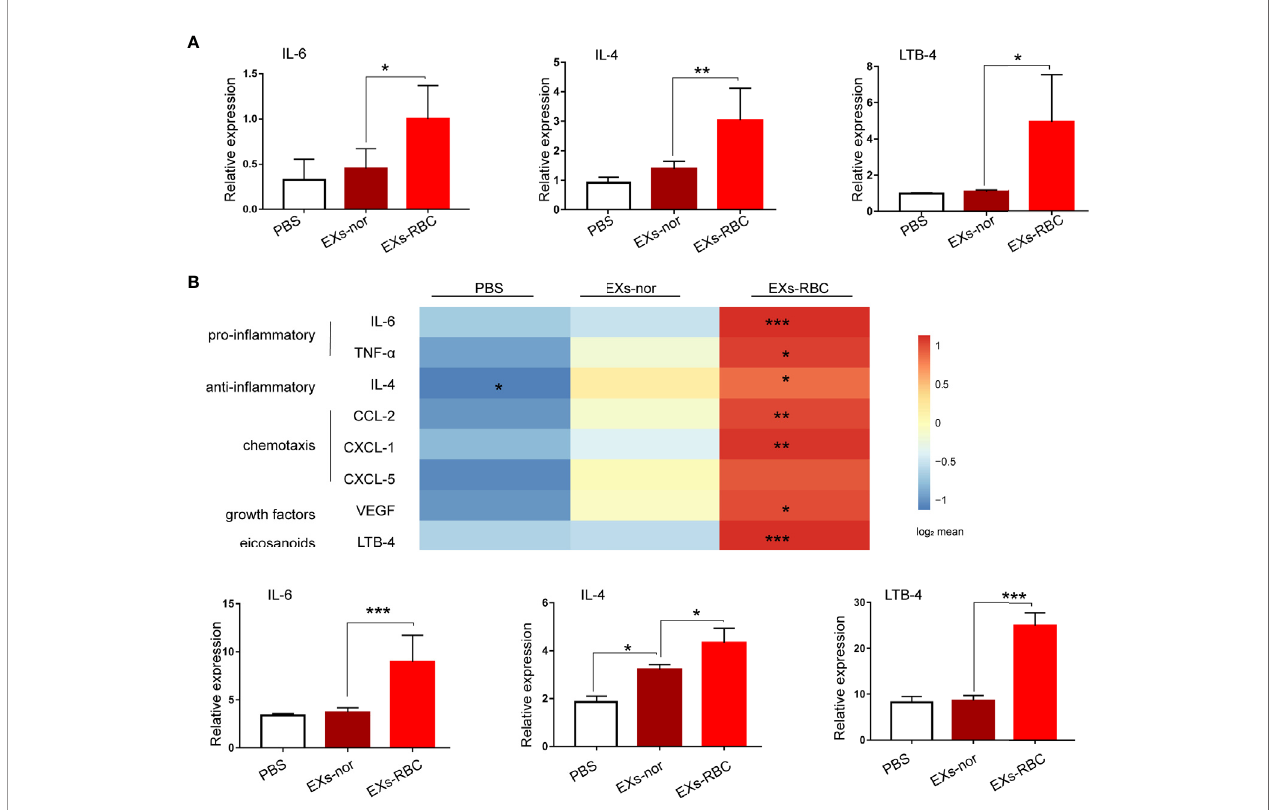
FIGURE 4 | EXs-RBC exposure upregulates the expression and secretion of multiple mediators in HMC-1 cells. HMC-1 cells were cultivated with PBS, EXs-nor, and EXs-RBC. Cells were collected for qPCR at 2 h. Supernatants were collected for ELISA at 8 h. Data were from 2 – 4 independent trials. ANOVA and multiple comparisons were applied to test the differences between EXs-nor and EXs-RBC groups. * means a statistical difference between groups. (*P < 0.05; **P < 0.01; ***P < 0.001). Here, the results of IL-6, IL-4, and LTB-4 are shown, whereas the results for other in fl ammatory mediators are shown in Supplementary Figure 1 . (A) qPCR results. (B) ELISA outcomes. Upper panel: results of mediator concentrations in supernatants stimulated by PBS, EXs-nor, and EXs-RBC; data are shown using the method of the heat picture according to the log 2 transformed average value from 2 – 4 independent trials. EXs-nor, exosomes from normal volunteer plasma; EXs-RBC, exosomes from red cell